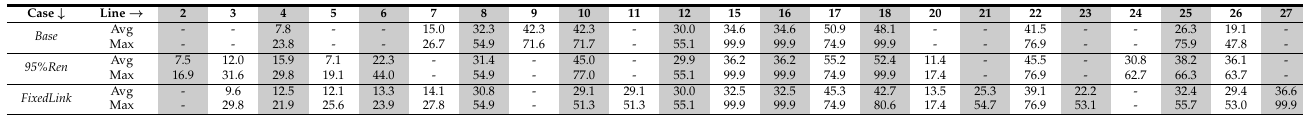
Table 14. Average (Avg) and maximum (Max) usage of new installed lines